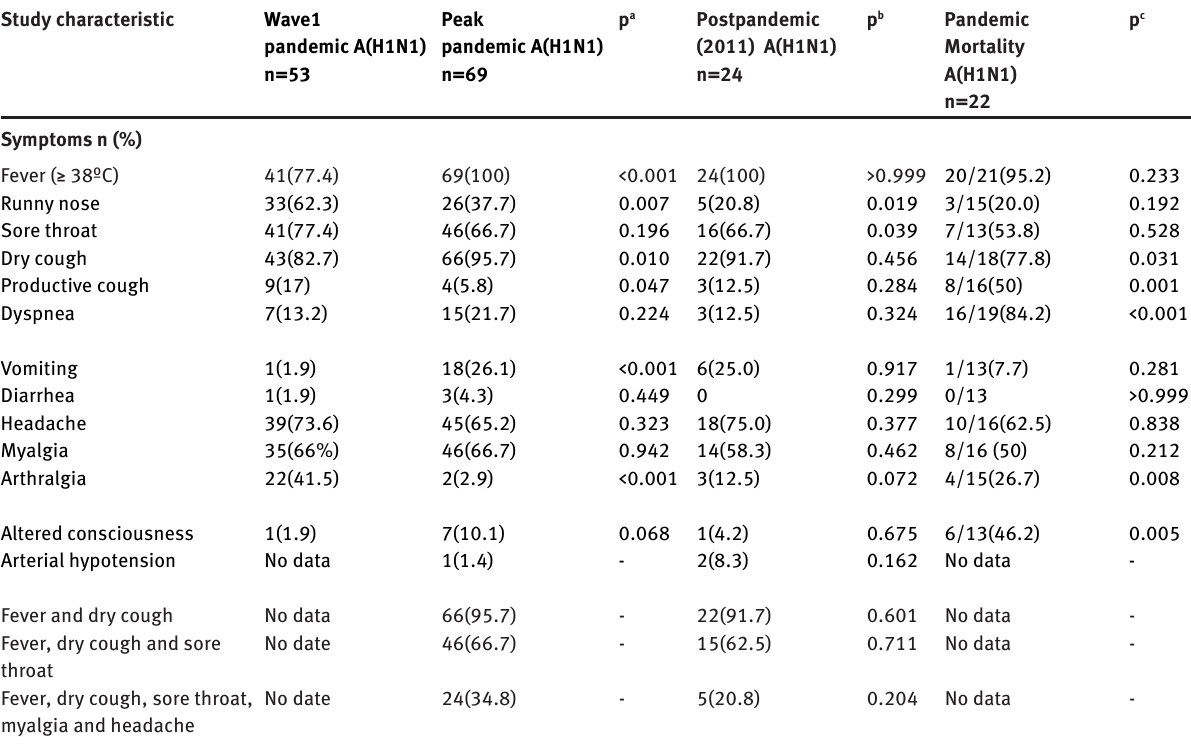
Table 2: Presenting symptoms of patients with influenza A(H1N1)pdm09 and postpandemic (2011) influenza Study